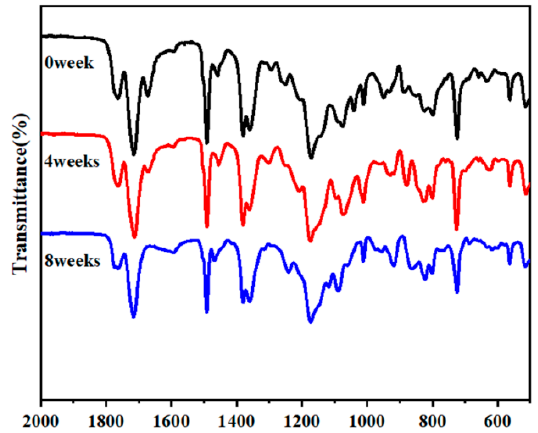
Figure 10. FTIR spectra of the PEI3a in every stages of degradation.